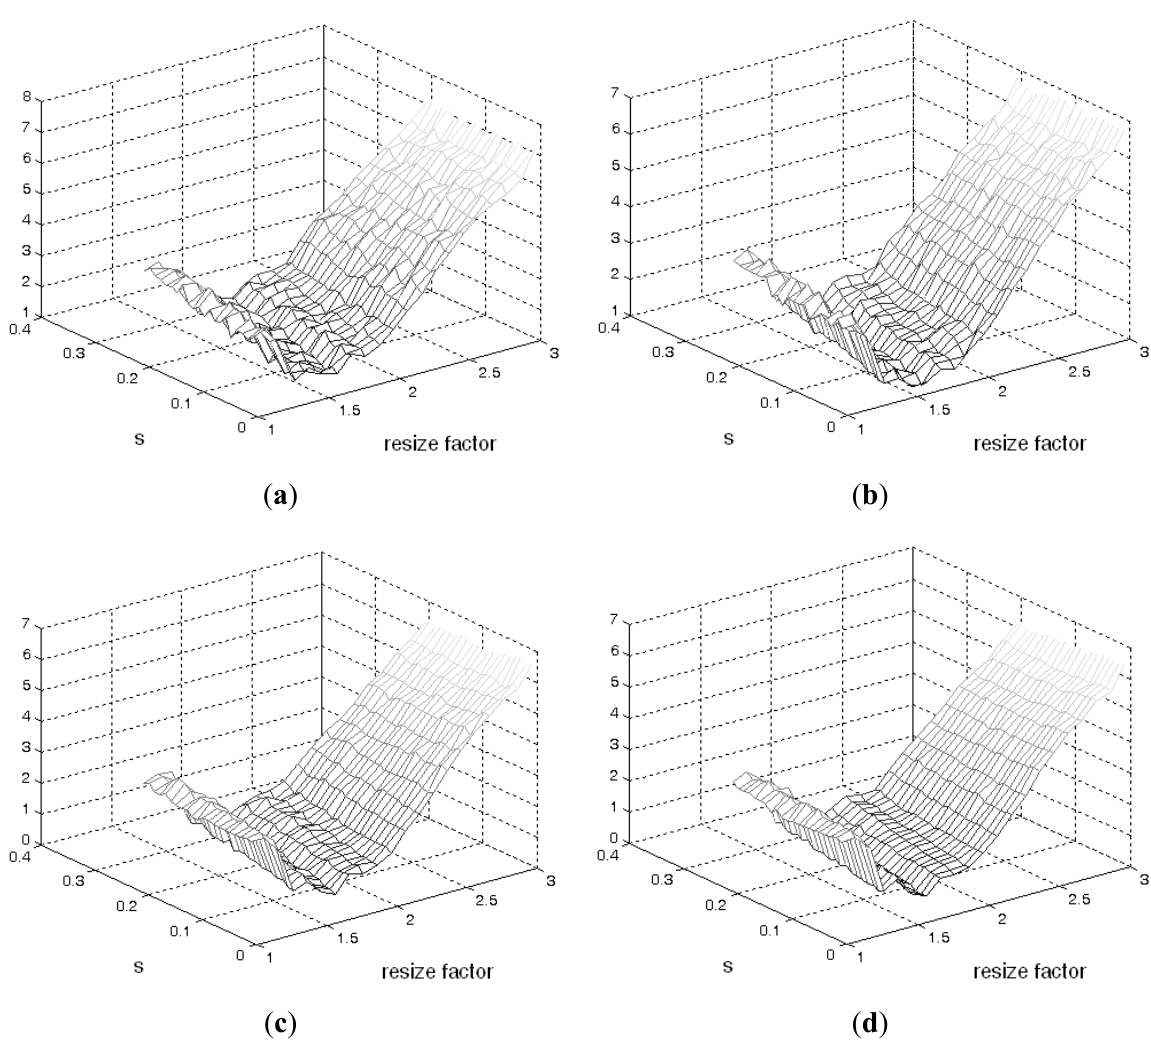
Figure 5. The unsigned error plots of different phantom images. SNR is ( a ) 14 dB,